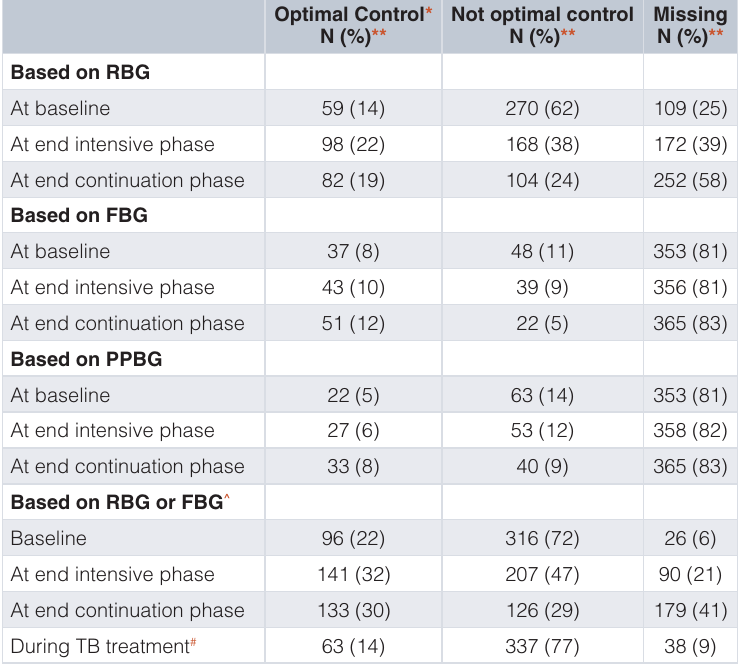
Table 2. Glycemic control at different stages of treatment among patients with TB-DM registered in RNTCP in select districts of Tamil Nadu, India (Jan–Sept 2016)